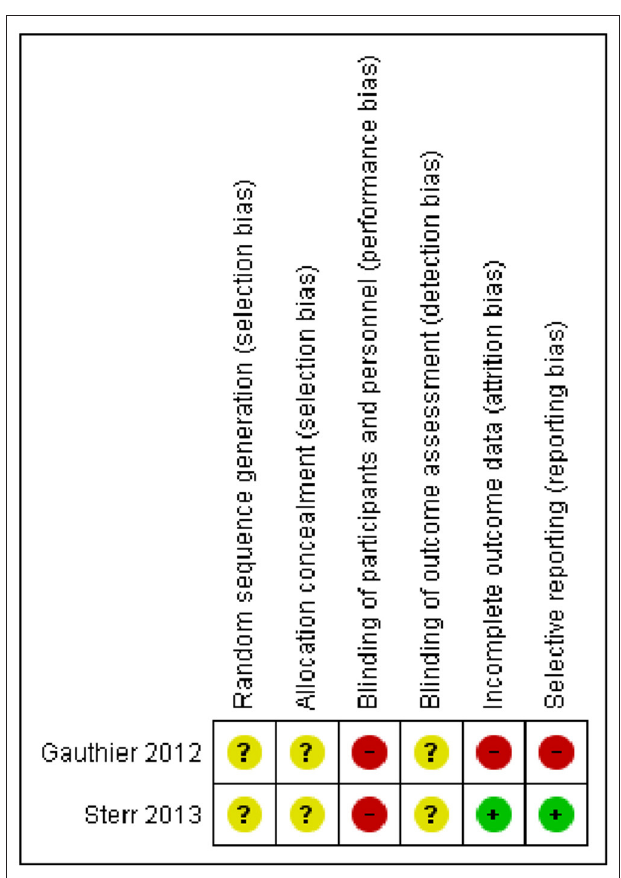
FIGURE 2 | Risk of bias summary for Randomized Controlled Trials. Depicted are the review authors’ judgements about each risk of bias item for the two included randomized controlled